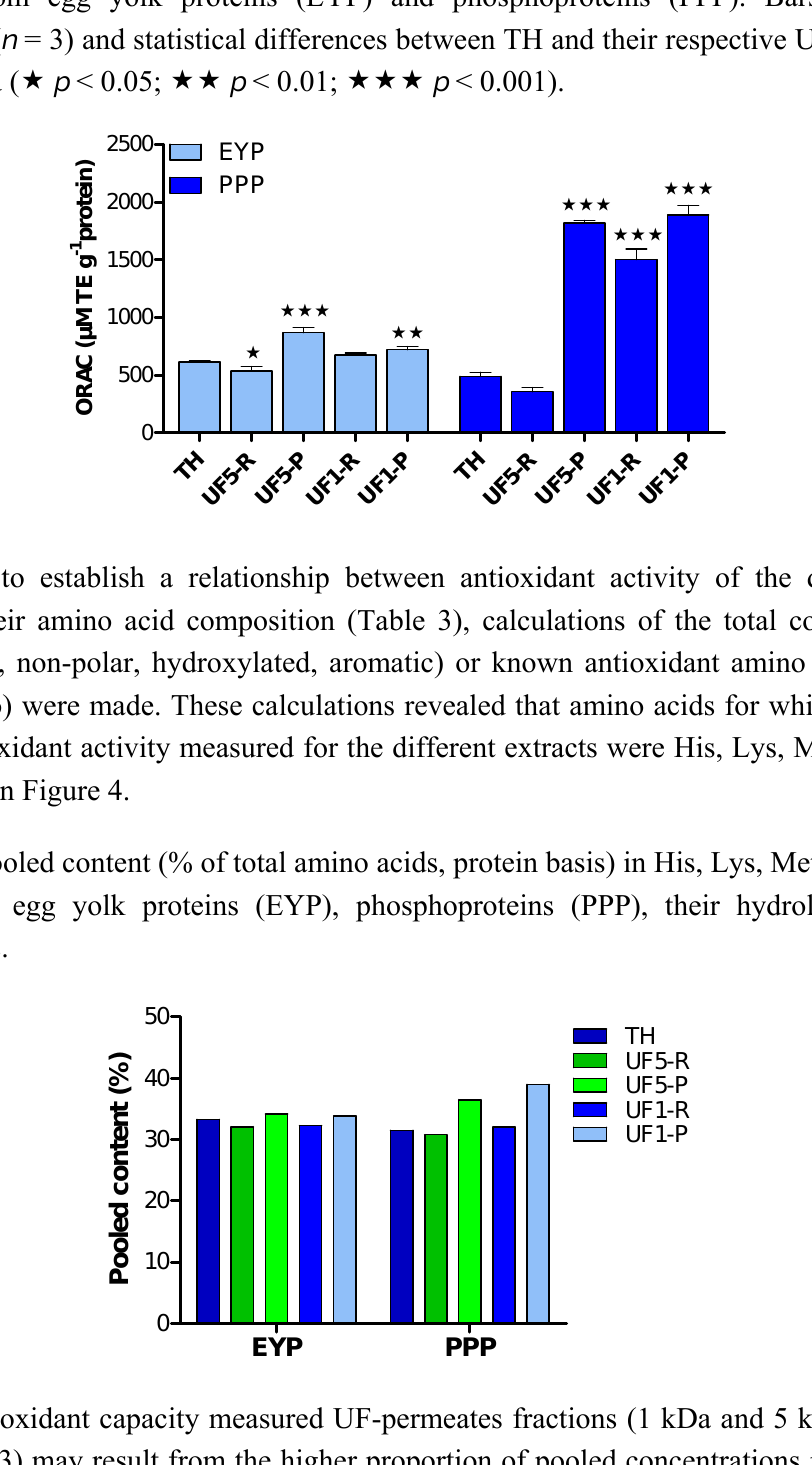
Figure 3. Antioxidant activity (µM TE ⋅ g − 1 protein) of hydrolysates (TH) and UF-fractions prepared from egg yolk proteins (EYP) and phosphoproteins (PPP). Bars represent mean ± SD ( n = 3) and statistical differences between TH and their respective UF-fractions